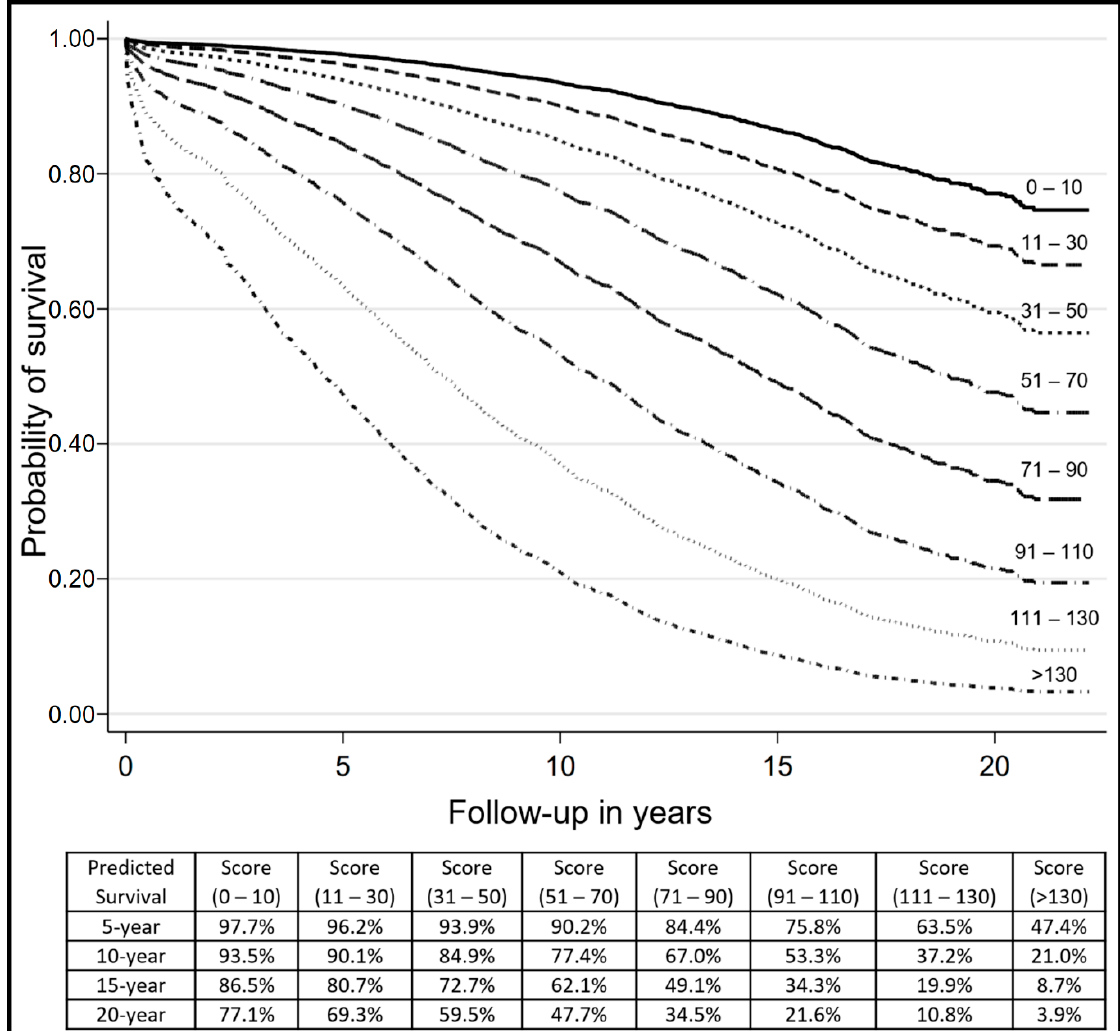
Figure 3. Prediction survival curves adjusted for the time-varying coefficient of the score in 8 subgroups according to the points total in the isolated CABG-BITA dataset ( n = 2846). There were used cut off points at round numbers 0–10 ( n = 233), 11–30 ( n = 389), 31–50 ( n = 414), 51–70 ( n = 621), 71–90 ( n = 502), 91–110 ( n = 289), 111–130 ( n = 259) and >130 ( n = 139). Female gender and BMI are well ‐ known risk factors affecting the outcome of CABG; therefore, it assessed specifically the impact of the score on outcome in males relative to females, as well as among the four BMI groups. Figure 4A shows that CABG ‐ BITA is associated with improved outcomes in females with a score higher than 85 compared to males. Morbid obesity (BMI ≥ 40 kg/m 2 ) carries a very high risk of mortality in a score higher than 125, and underweight patients (BMI < 18.5 kg/m 2 ) remain at higher risk for mortality at scores from 0 to 125 in comparison to all other BMI categories (Figure 4B).